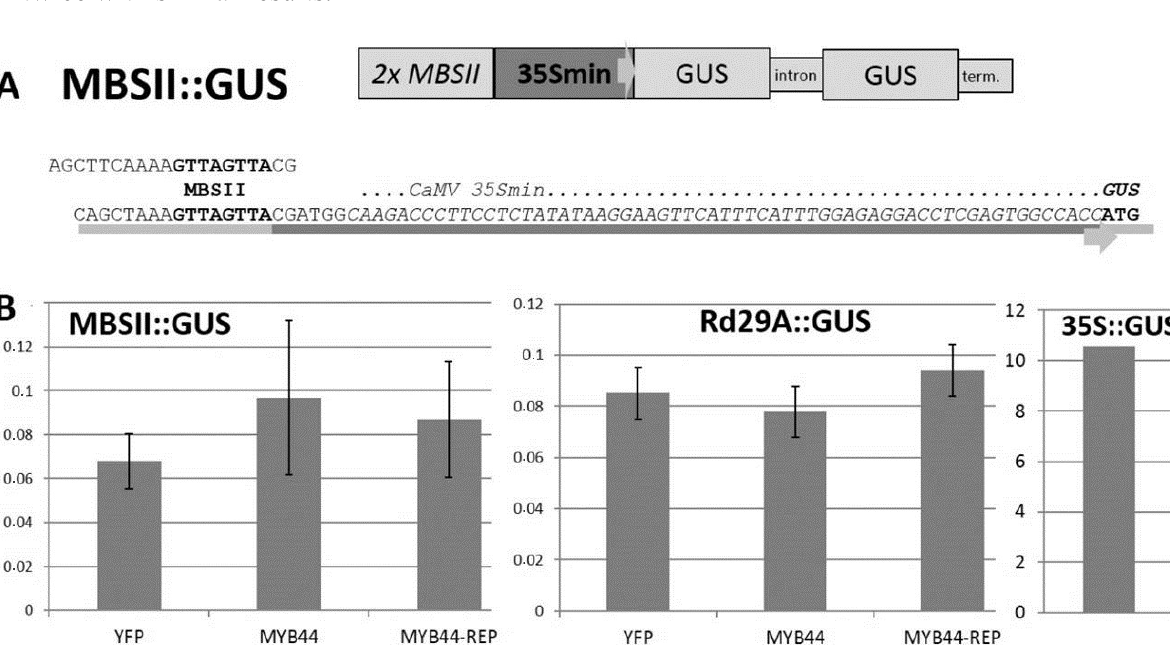
is approximately 100 times higher than in MBSII or Rd29A. The experiment was repeated twice with similar